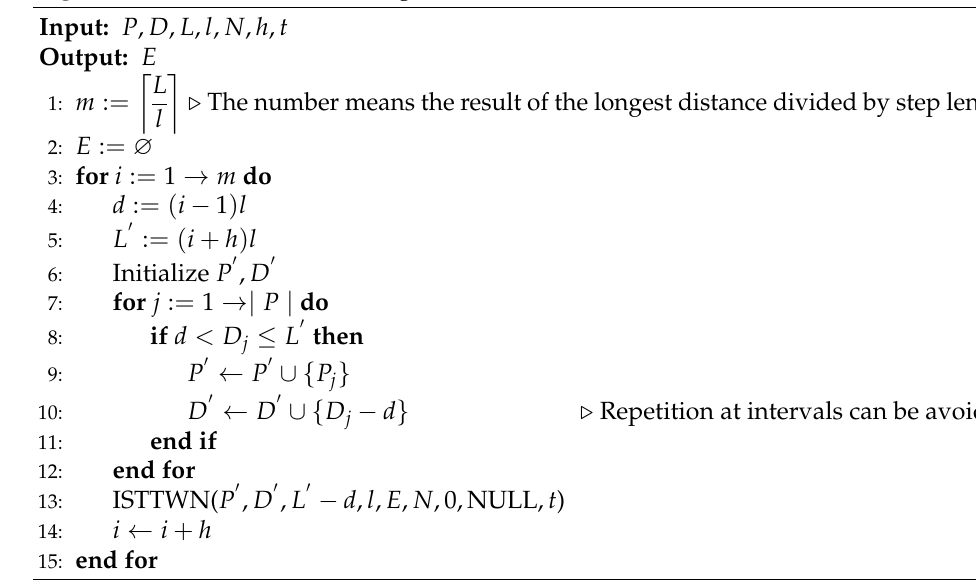
Algorithm 2 Iterative ISTTWN